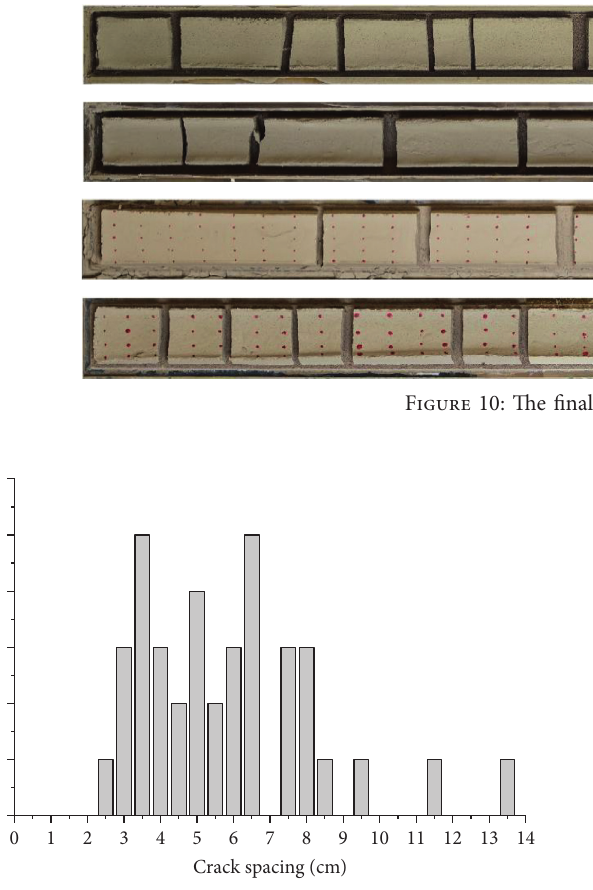
Figure 11: Distribution of the crack spacing.